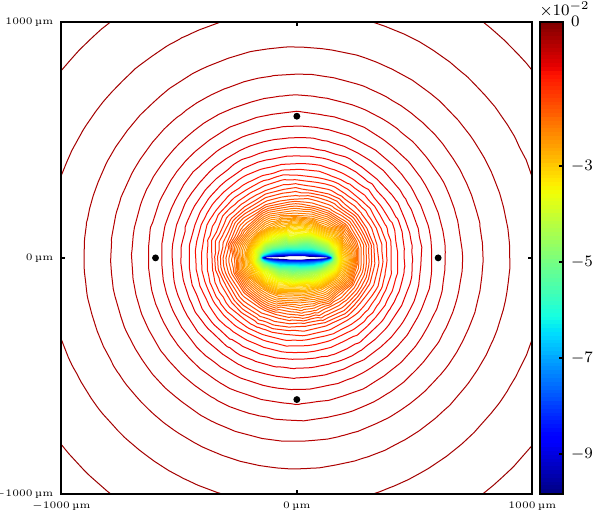
Figure A1. Contour lines of the supersaturation with respect to wa- ter around the ice crystal at time instant 5s. Although the compu- tational domain is a cuboid with edge length 6000µm, the figure shows only a reduced cuboid with edge length 2000µm centered around the ice crystal. The black dots show the positions of the droplets with coordinates ( ± 600µm , 0 , 0 ) and ( 0 , ± 600µm , 0 )